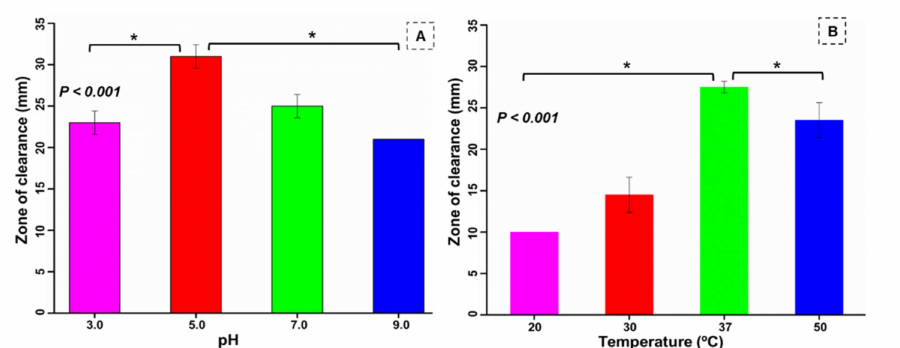
Figure 4. Effect of pH ( A ) and temperature ( B ) on the cellulose-degrading activity of the potential bacterium. Results are presented as average ± standard deviation of five experimental replicates. The asterisk (*) over the bars indicates p value statistically significant at <0.01 for optimum pH (pH 5.0) and temperature (37 ◦ C) when compared with other related